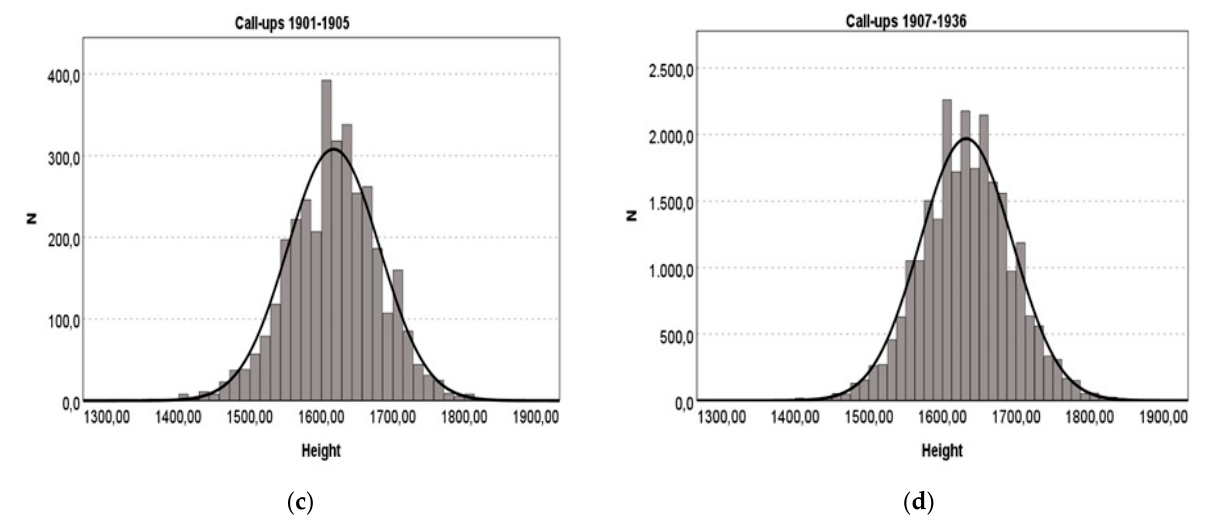
Figure A1. Histograms with the distributions of heights. Call-ups 1858–1936 (Source: built with data from the corresponding Expedientes ). Data expressed in thousands with “.” and decimals with “,” in the axes.